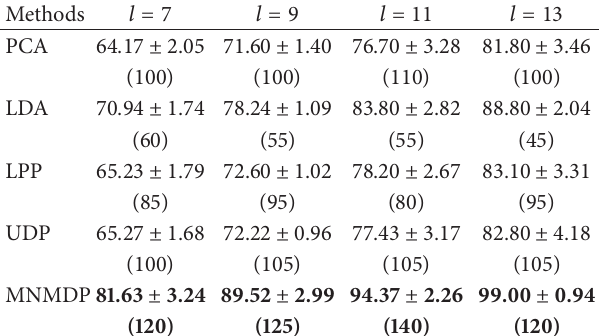
Figure 8: The average recognition rates of MNMDP versus 𝑊𝑘 on AR. Table 3: The maximal average recognition rates (%) of each method on AR with the corresponding standard deviations (stds) and values of dimension in the parentheses.